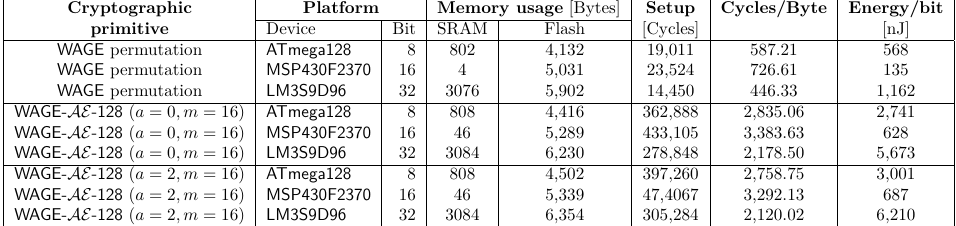
Table 9: Performance of WAGE on microcontrollers at clock frequency 16